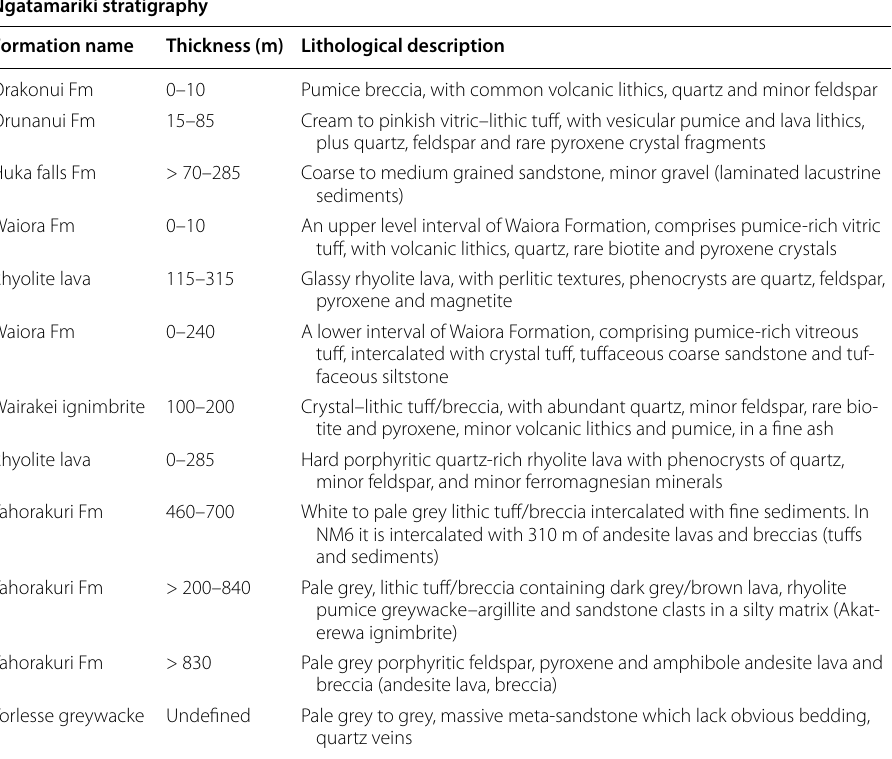
Table 1 Subsurface lithology of Ngatamariki from wells NM1-7, as described by